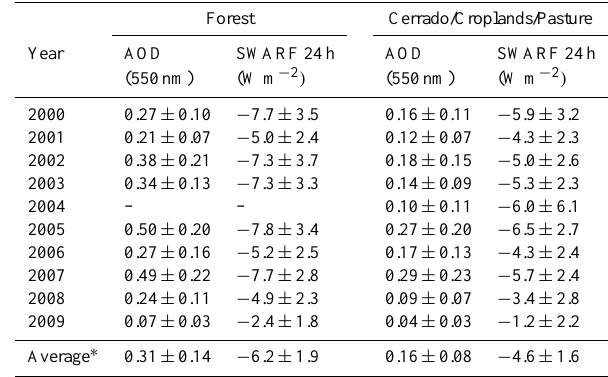
Table 5. Mean aerosol optical depth at 550nm (AOD) and daily SWARF for forest and cerrado/croplands/pasture regions with their respective standard deviation. These calculations were performed for the biomass burning season of the years 2000 to 2009. The stan- dard deviation represents the spatial variability of each parameter.